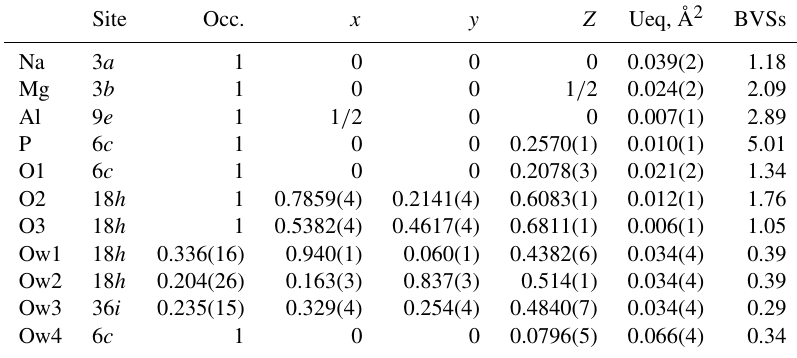
Table 4. Atom coordinates for tomsquarryite.